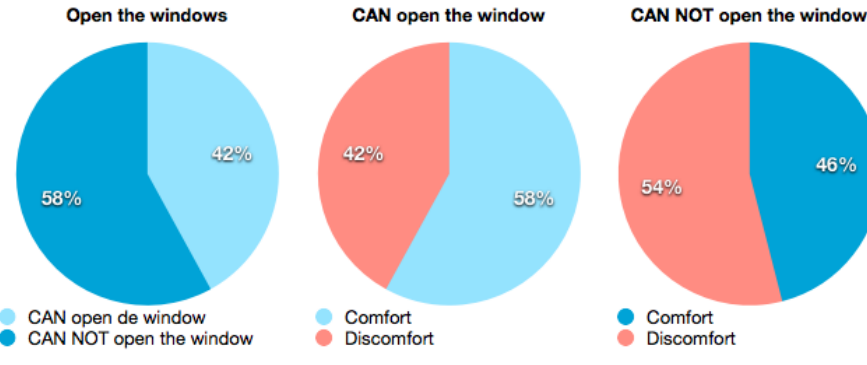
Figure 7. People’s discomfort correlated with the operability of windows.